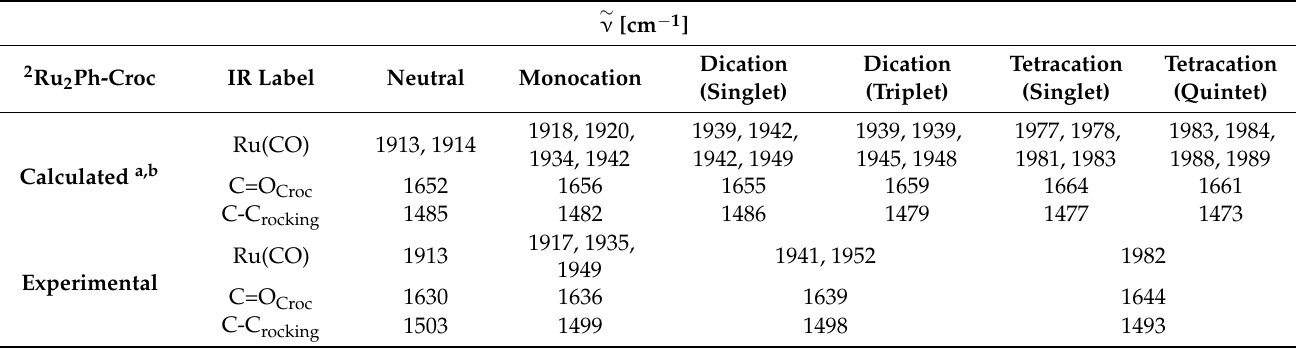
a Calculated with the pbe1pbe/6-31G(d) functional. b The computed ground state is indicated in bold